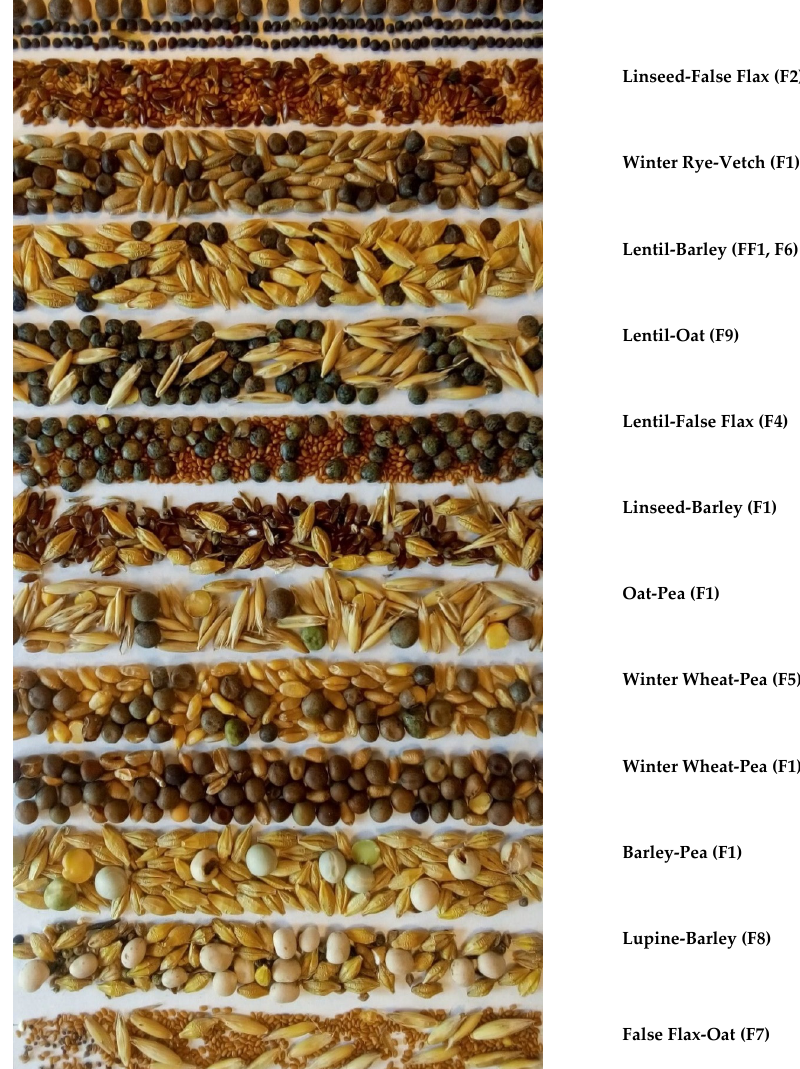
Figure 1. Mixtures sampled from the interviewed farmers. Photo by Ties Ruigrok.